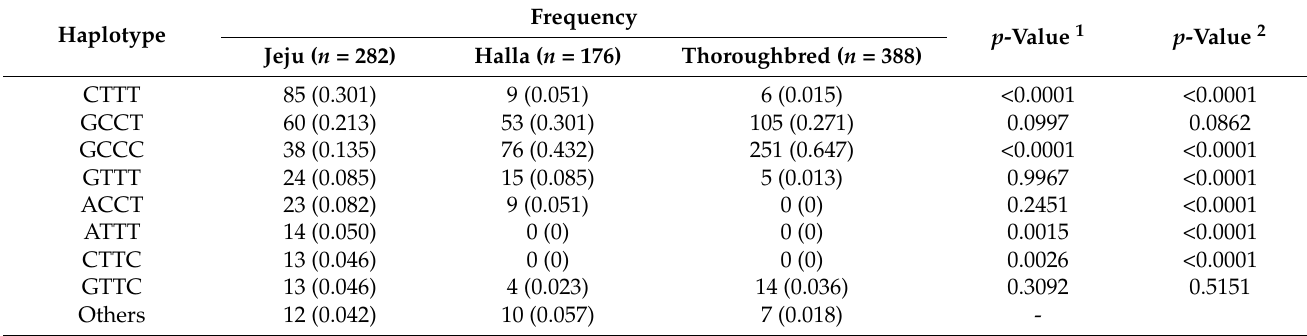
Table 2. Haplotype frequency of four shadow of prion protein gene ( SPRN ) SNPs in Jeju, Halla and Thoroughbred horses. Haplotype